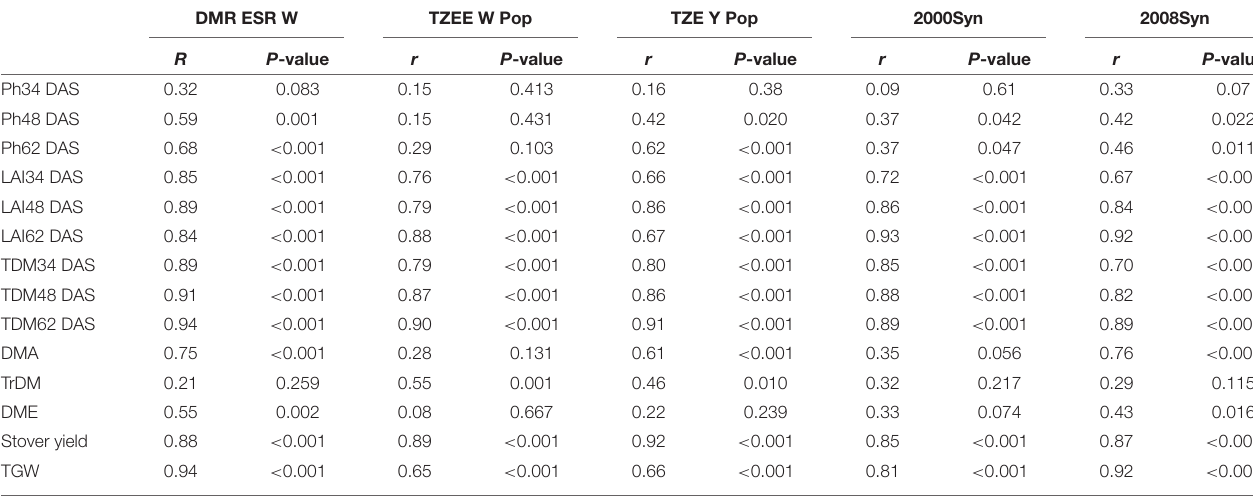
TABLE 6 | Relationship between maize grain yield and other agronomic variables taken over the two cropping seasons (two-sided test of correlations different from zero, r , and probabilities, P ). DMR ESR W TZEE W Pop TZE Y Pop